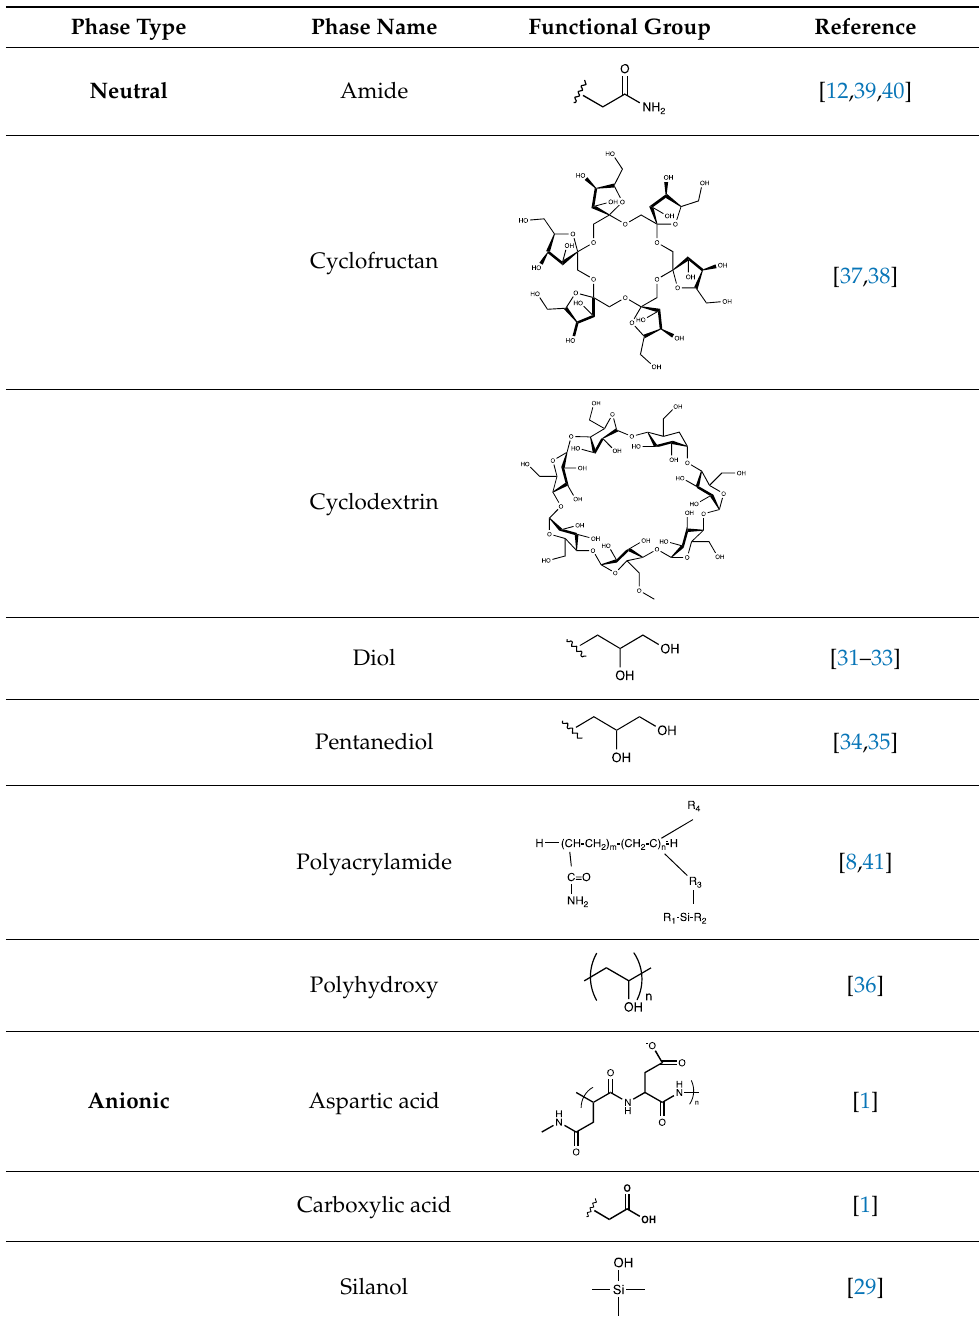
Figure 2. Fourteen aminoglycosides standard solution separated on the four selected stationary phases with optimised conditions. Reproduced with permission [47].